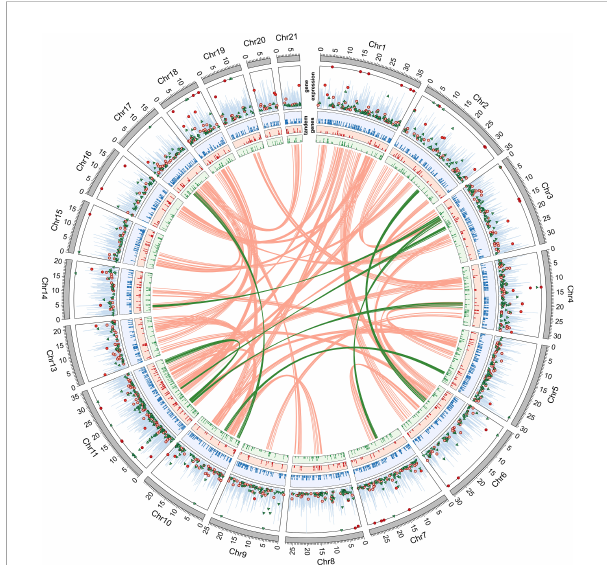
FIGURE 1 CIRCOS plot of duplicated genes in Caligus rogercresseyi resistant (R) and susceptible (S) strains and the chromosome regions implicated in the duplications. The fi rst track corresponds to the gene expression of susceptible and resistant strains calculated by the Fold Change of TPM values of parasites treated with azamethiphos versus control samples. Only signi fi cant expression changes are shown (|Fold change| > 4.0; P-value < 0.01). Red circles correspond to resistant strain, green triangles to susceptible strain, and blue lines to the reference TPM values of the sea lice genome. The second track corresponds to the position of duplicated genes in tandem. Blue tiles correspond to the tandem genes in the reference genome, red to the resistant strain, and green to the susceptible strain. Links correspond to duplicated collinear genes in different pairs of genome regions. Red links correspond to collinear genes in the resistant strain and green to the susceptible